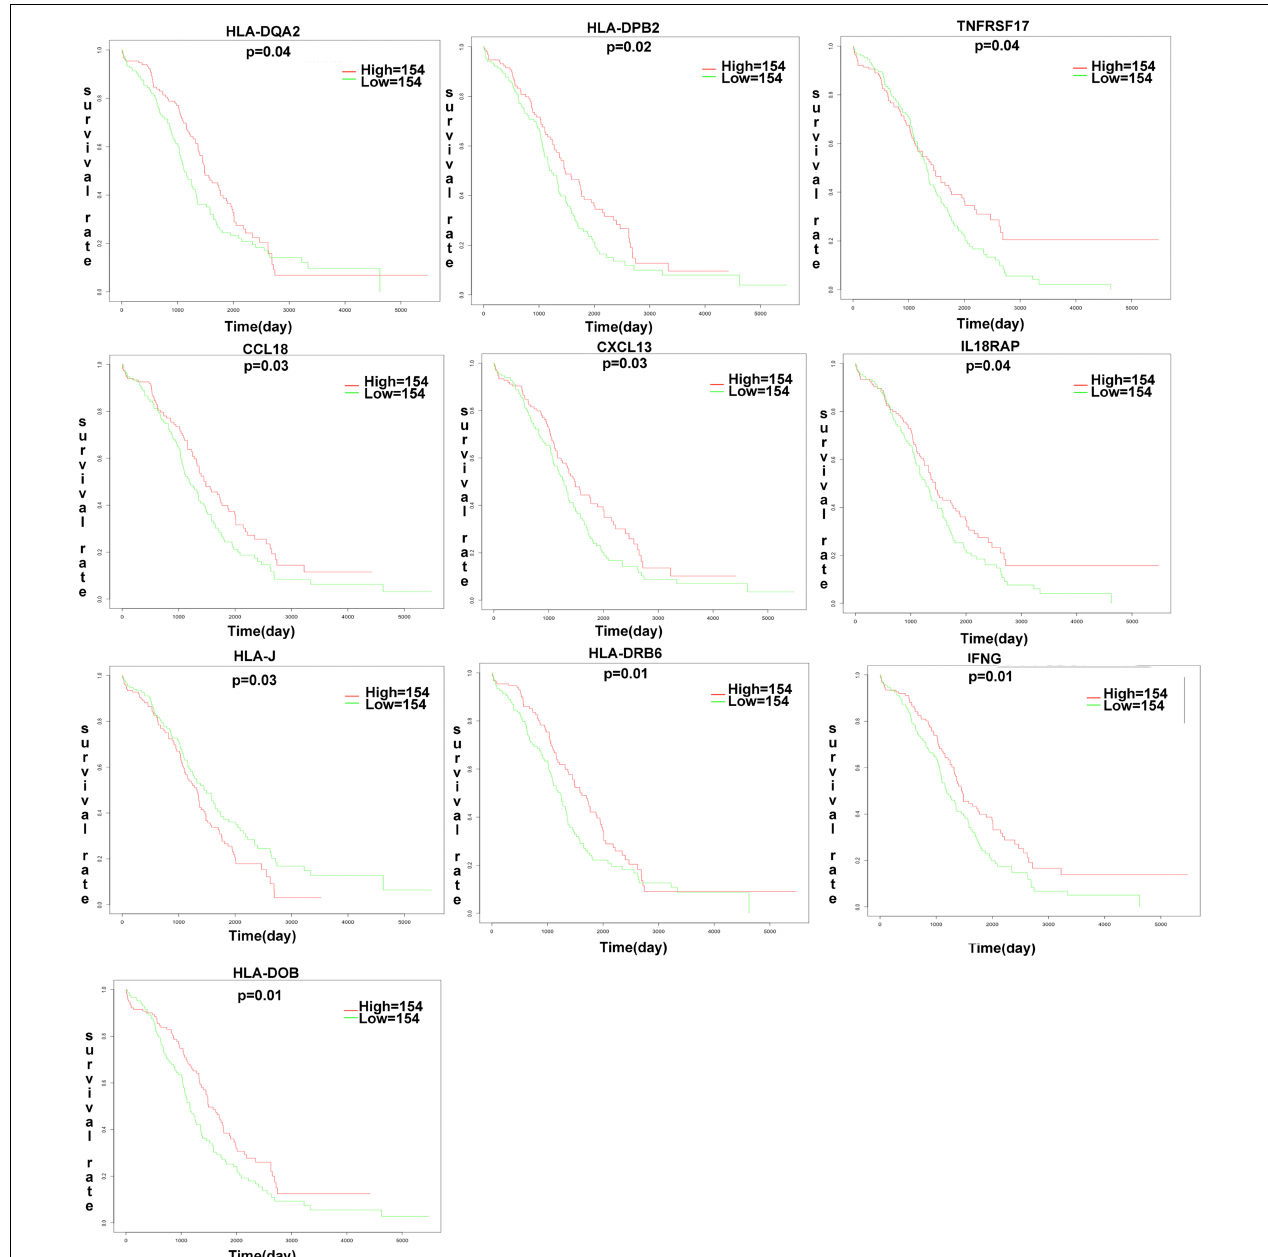
FIGURE 7 | The K-M plot analysis revealed that 10 out of 118 DEIRGs were significantly associated with OC overall survival ( p < 0.05), including CCL18, CXCL13, HLA-DOB, HLA-DPB2, HLA-DQA2, HLA-DRB6, HLA.J, IFNG, IL18RAP, TNFRSF17. P -value was verified by log-rank